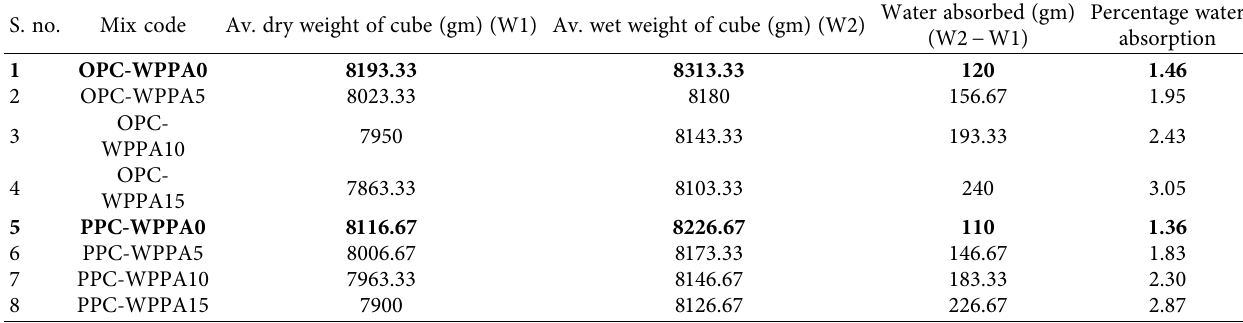
Table 13: Water absorption test results of OPC-WPPA and PPC-WPPA concrete after 28 days of curing. S. no. Mix code